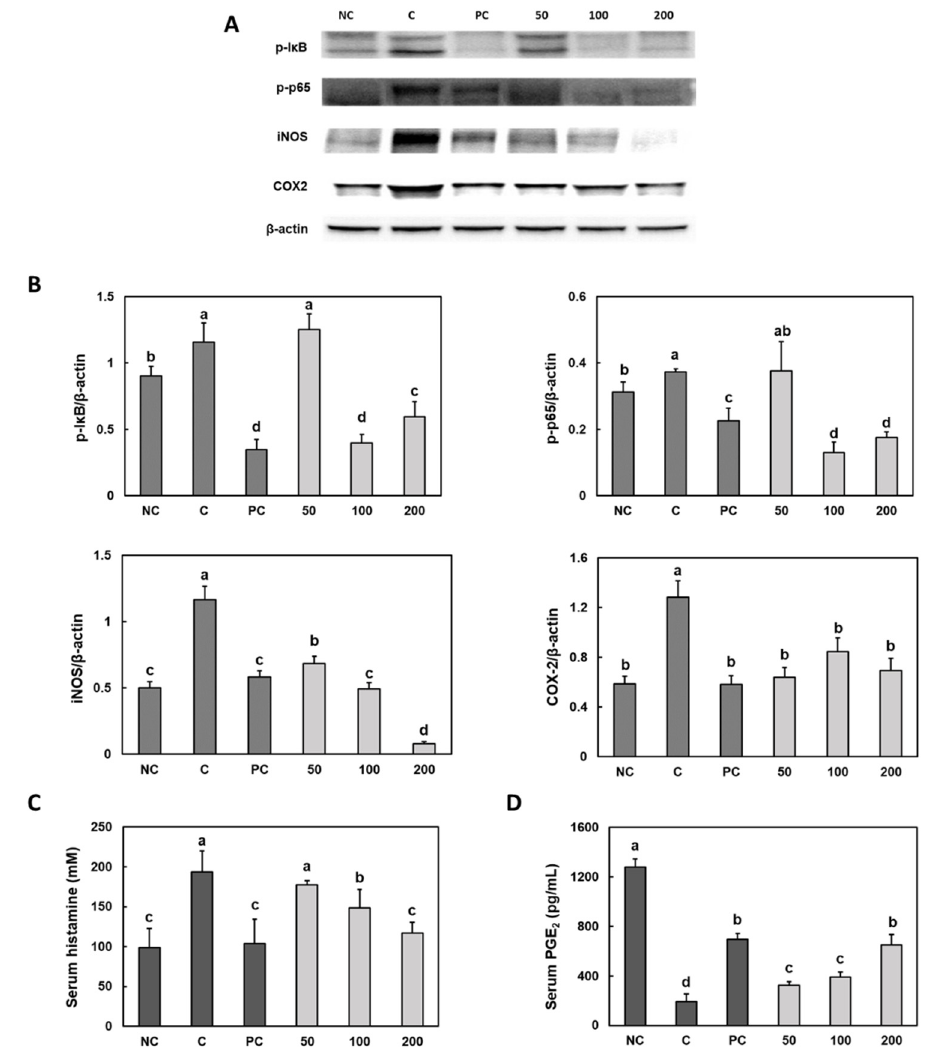
Figure 4. Effect of Gastro-AD ® on the inflammatory factors and PGE 2 in gastric damage induced by ethanol/HCl treatment in SD rats. The protein expression of inflammatory factors ( A ), band image; ( B ), quantification of bands) and the levels of serum ( C ) histamine and ( D ) PGE 2 . Normal control (NC; − ethanol/HCl); ethanol/HCl control (C); ethanol/HCl with 30 mg/kg b.w. of rebamipide (positive control; PC); ethanol/HCl with 50 mg/kg b.w. of Gastro-AD ® (50); ethanol/HCl with 100 mg/kg b.w. of Gastro-AD ® (100); and ethanol/HCl with 200 mg/kg b.w. of Gastro-AD ® (200). Values are presented as mean ± SD ( n = 8). Different letters indicate a significant difference, with p < 0.05, as determined using Duncan’s multiple range test.